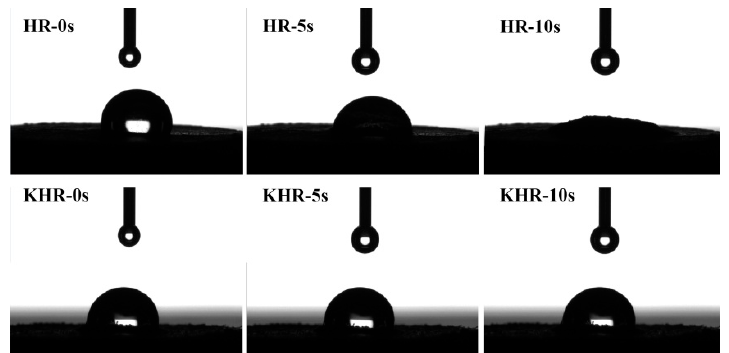
Figure 3. The water contact angle of the HR and